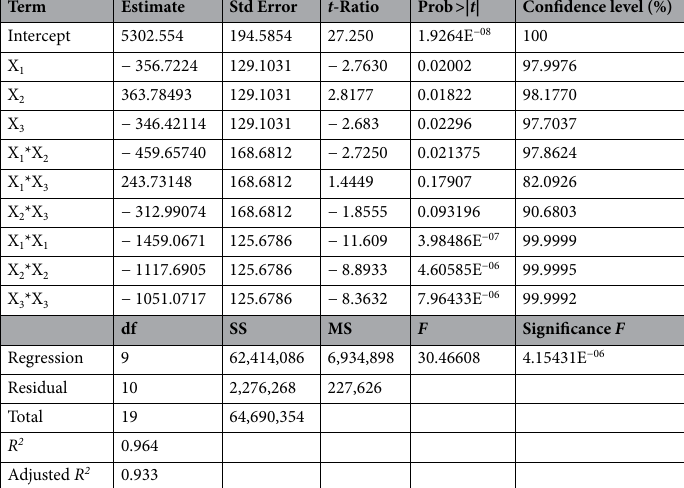
Table 4. Statistical analysis of CCD-uniform precision showing coefficient values, t -values, and p -values for each variable on ALP activity.